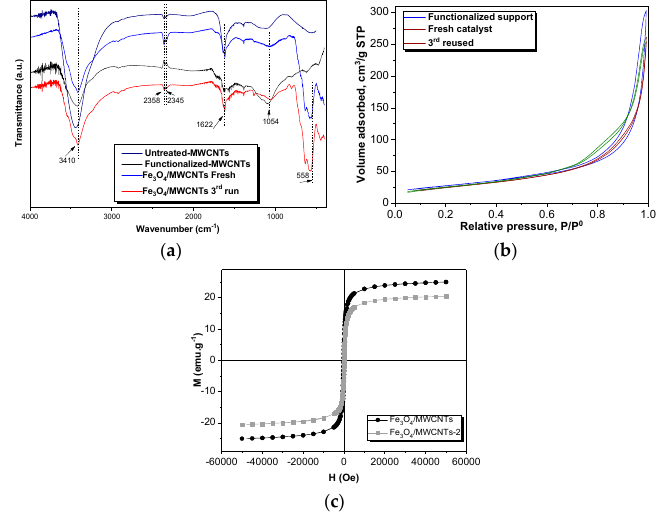
Figure 2. ( a ) FT-IR spectra of the untreated, functionalized support, and catalysts (fresh and reused); ( b ) N 2 adsorption–desorption isotherms at 77 K of the functionalized support and the catalyst (fresh and third reuse); ( c ) magnetization hysteresis loop of Fe 3 O 4 /MWCNTs and Fe 3 O 4 /MWCNTs-2 (second reuse).